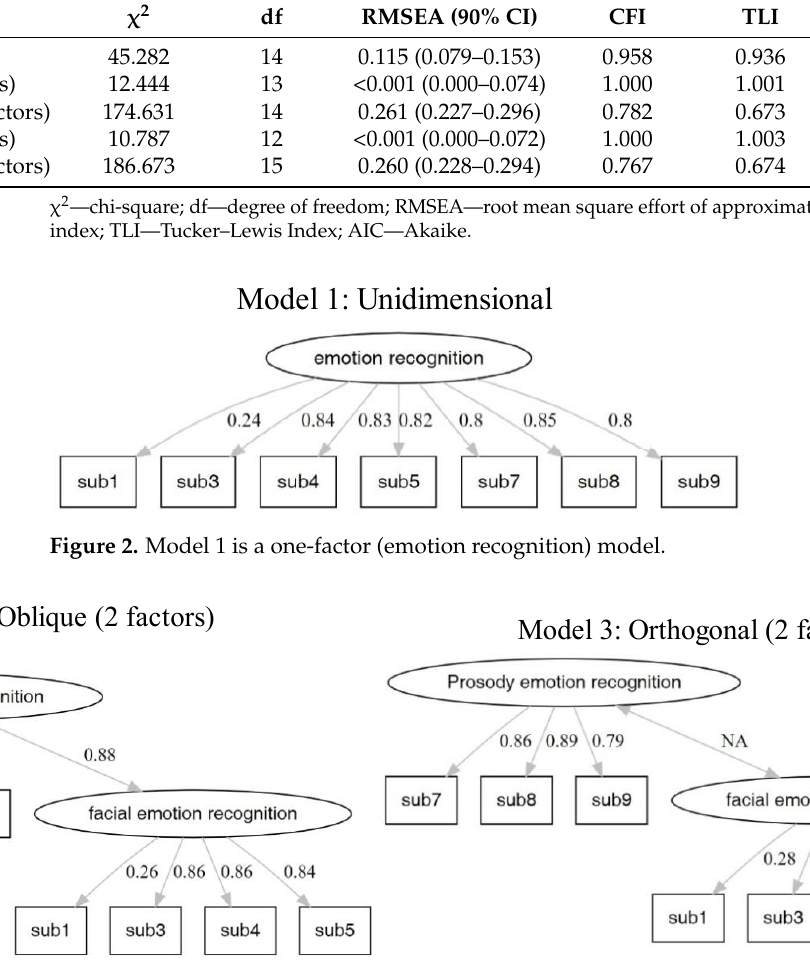
Figure 3. Model 2 and 3 are two-factor (prosody emotion recognition and facial emotion recognition) models with oblique and orthogonal rotation, respectively.